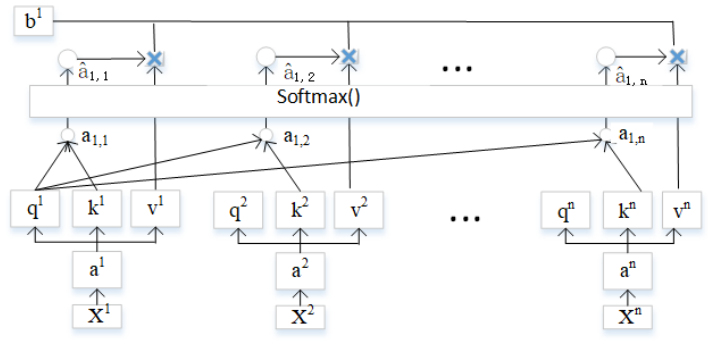
Figure 2. Basic attention